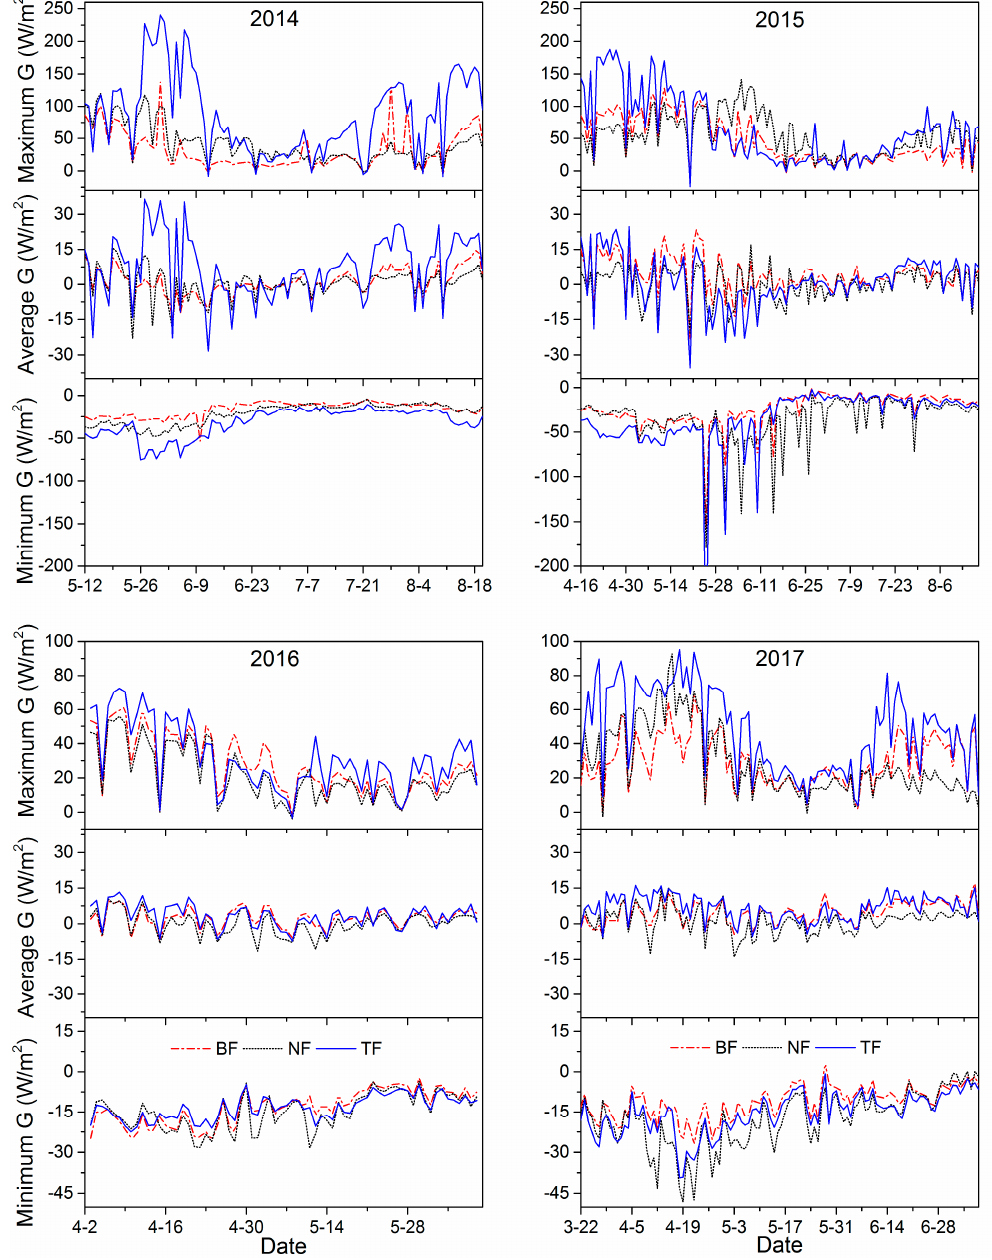
Figure 3. Seasonal variations of the daily maximum soil heat flux (G max ), daily average soil heat flux (G avg ), and daily minimum soil heat flux (G min ) at 5 cm depth in the top of the beds for different mulch treatments: black film (BF), no film (NF), and transparent film (TF) in 2014–2017.